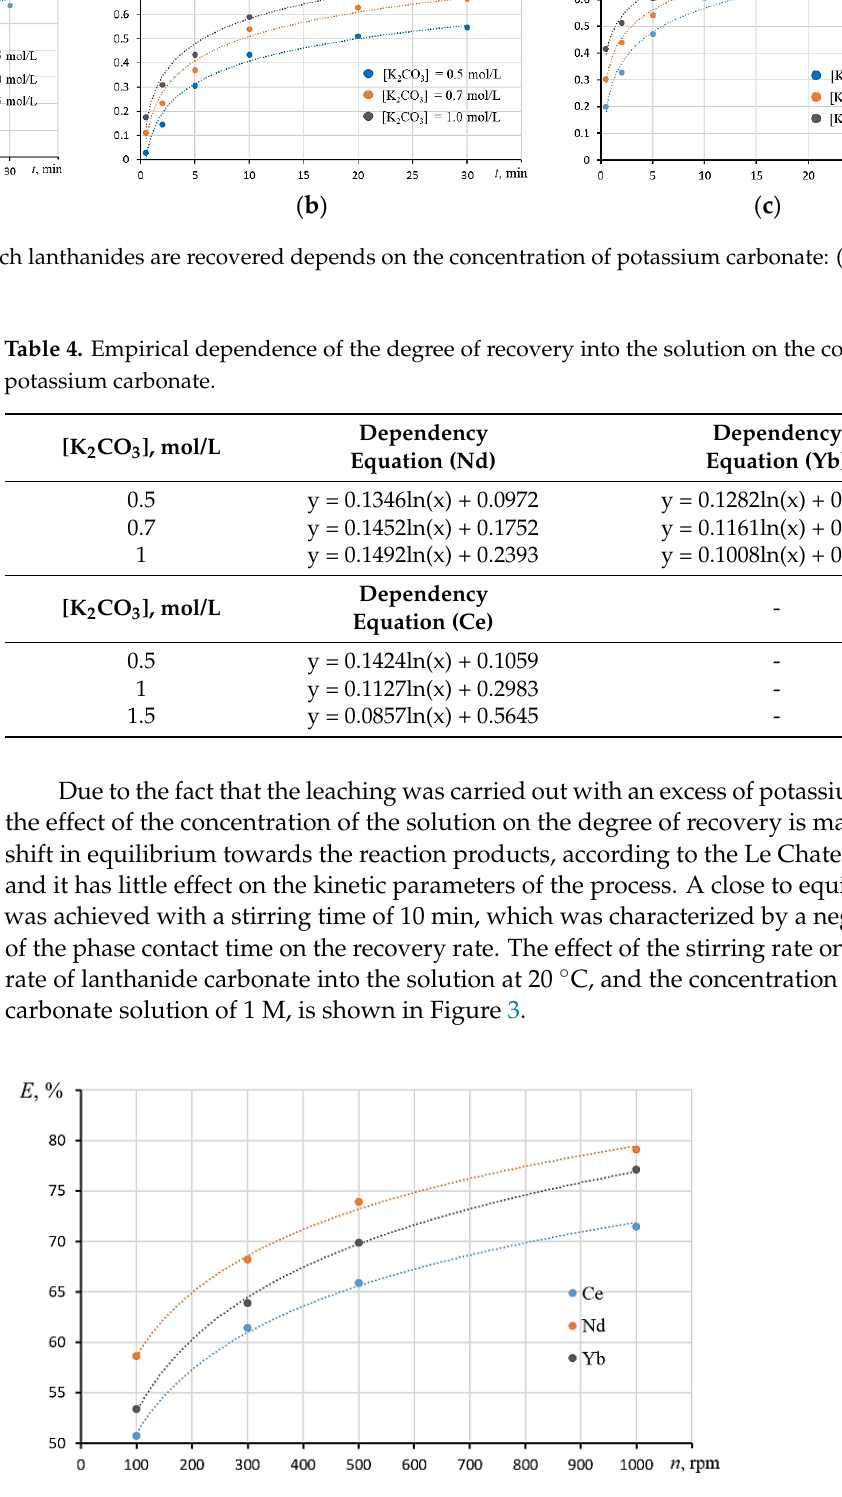
Figure 3. Lanthanide recovery rate versus mixing rate at a phase contact time of 10 min.